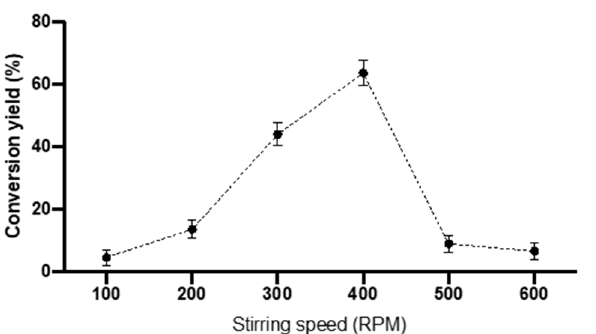
Figure 5. Effect of stirring speed on the enzymatic esterification of ibuprofen with sorbitol. Reaction conditions: PPL = 10 g L − 1 , T= 40 ◦ C, C IBU = 42 g L − 1 , C Sorbitol = 30 g L − 1 , C w = 10% v / v , volume ratio hexane/water = 10:1. Reaction time: 15h (equilibrium condition). All measurements were performed in triplicate.